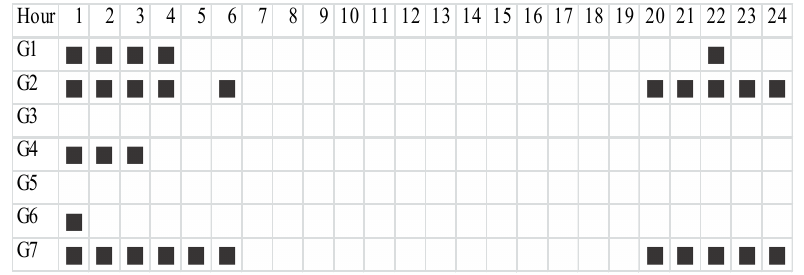
Figure 5. Activation of frequency constraints.